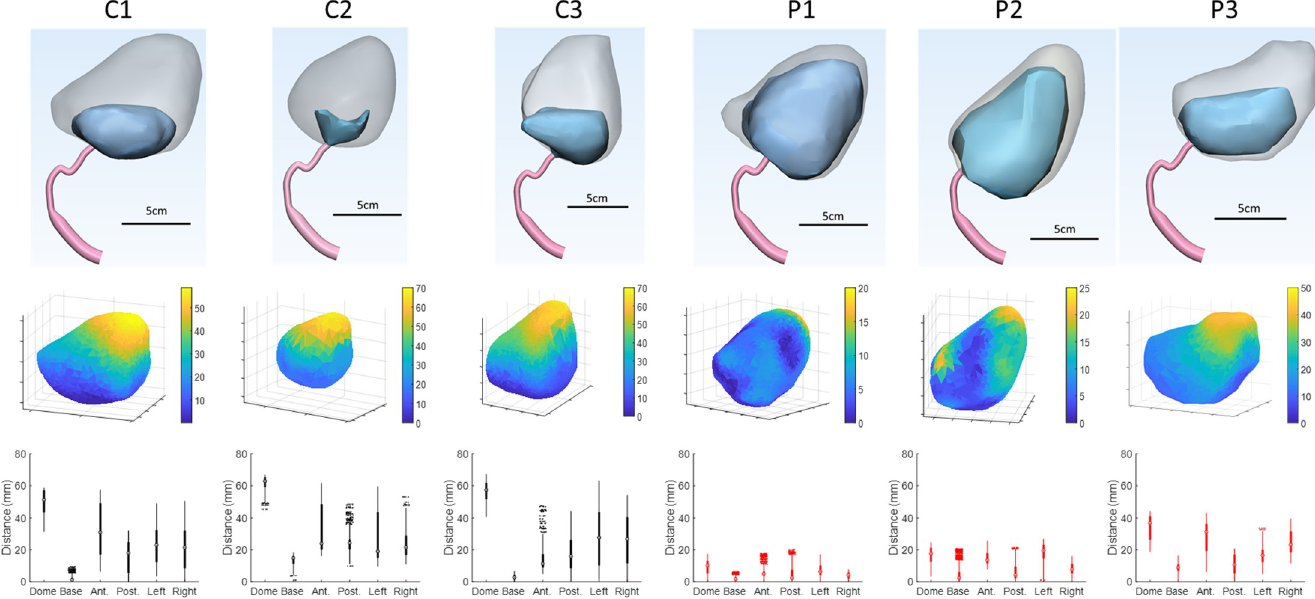
Fig 4. Top row: Pre- and post-voiding bladder anatomies for each subject. Middle row: Bladder wall displacement maps (in mm) for each subject. Note that the legend scale is much smaller for the men with BPH/LUTS. Bottom row: Box plots showing regional displacement behavior for each subject (C: Control; P: Patient).